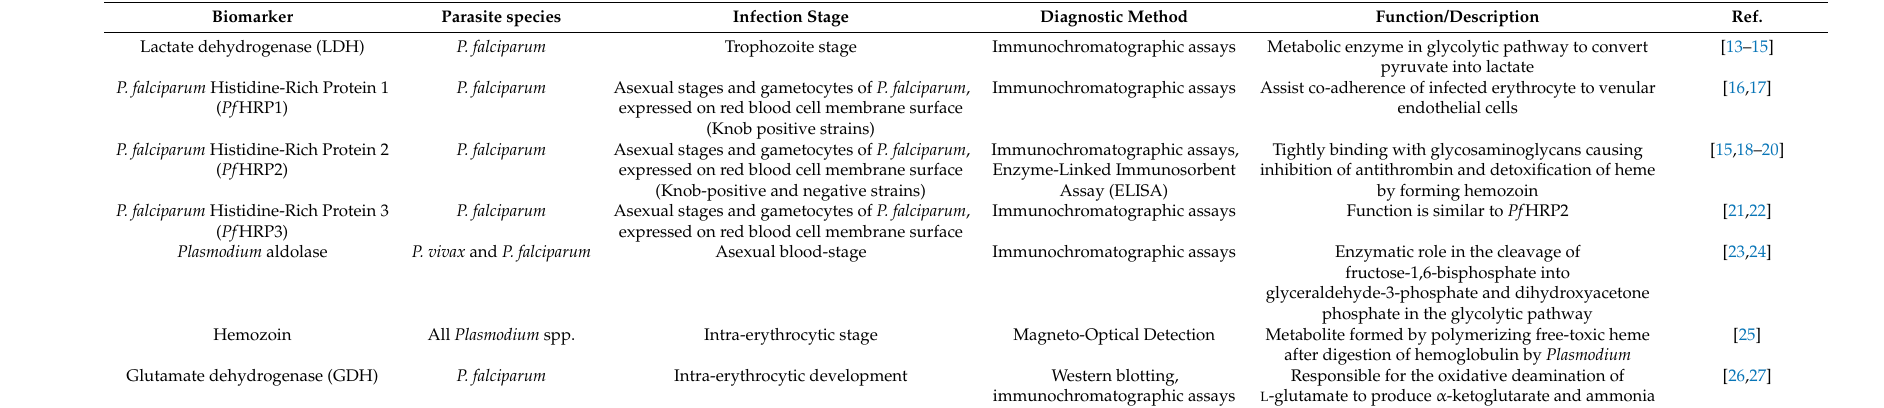
Table 1. Diagnostic biomarkers for